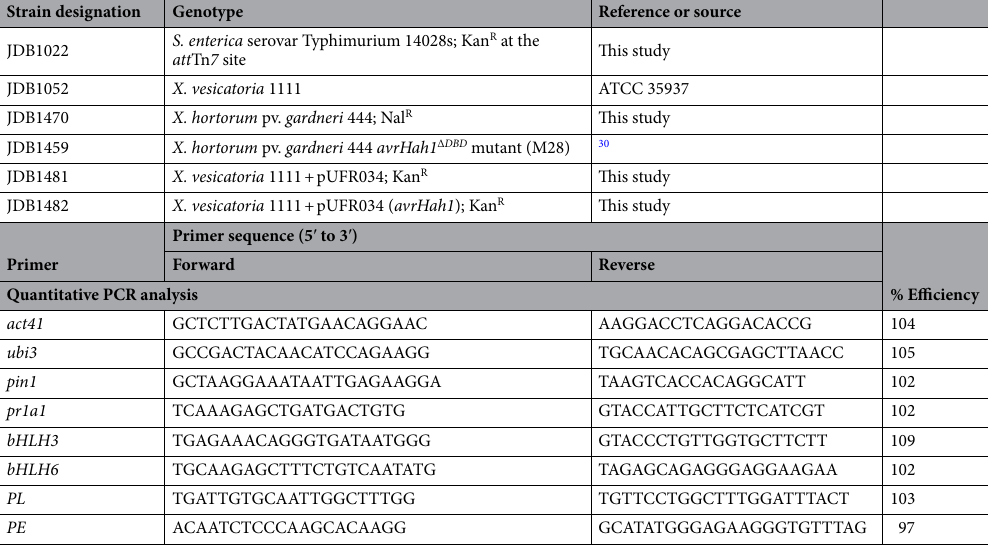
trated with Xhg wildtype or the avrHah1 ΔDBD mutant at OD 600 = 0.25, following published protocols 29 . At 48 h post-infiltration, two 79 cm 2 leaf discs were taken from each of two leaflets on middle leaves and combined for a total of four leaf discs per plant. Samples from four plants per treatment were collected and frozen at −80 °C for further processing, as described below. Bacterial population sampling. Bacterial populations on leaves were determined as described 14 . Briefly, at indicated times, one 79 cm 2 leaf disc was taken from a leaflet on middle leaves using a surface sterilized cork borer 18 . Samples from three plants per treatment per time point were individually homogenized in 500 µl of sterile water in microfuge tubes using a 4.8 V rotary tool (Dremel, Mt. Prospect, IL) with microcentrifuge tube sample pestle attachment (Fisher Scientific). Homogenates were diluted as needed and spiral plated (Autoplate